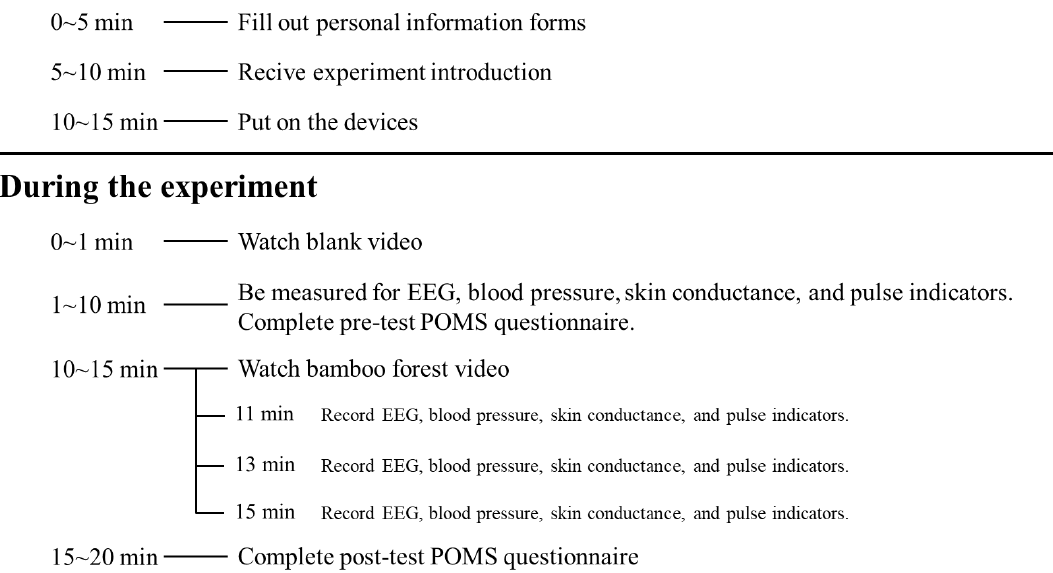
Figure 4. Participants in the experiment, (a) Participants were watching the urban bamboo forest videos; (b) Participants were being measured for EEG, blood pressure, skin conductance, and pulse during the experiment. 2.6. Data Collection EEG (high β, low β and α wave (HZ)) results were recorded using Neuro Harmony EEG biofeedback technology. EEG is a change in the electrical waves when the brain is active. It is the reflection of the electrophysiological activity of the brain’s nerve cells on the surface of the cerebral cortex or scalp. α waves and β waves can reflect the emotional changes in people after being stimulated by the outside world. High β appears when the human body is nervous, and low β waves often appear when people are thinking. β waves increase when the mind is nervous, anxious, and thinking about problems, and the α waves decrease or disappear when the mind is concentrated and relaxed [32,33]. Blood pressure (systolic (mmHg), diastolic (mmHg), and pulse (bmp)) was measured using a sphygmomanometer (Omron, HEM-6322T, Omron, Tokyo, Japan). Changes in psychological stress and mood can cause changes in cardiovascular activity, which in turn affects pulse and blood